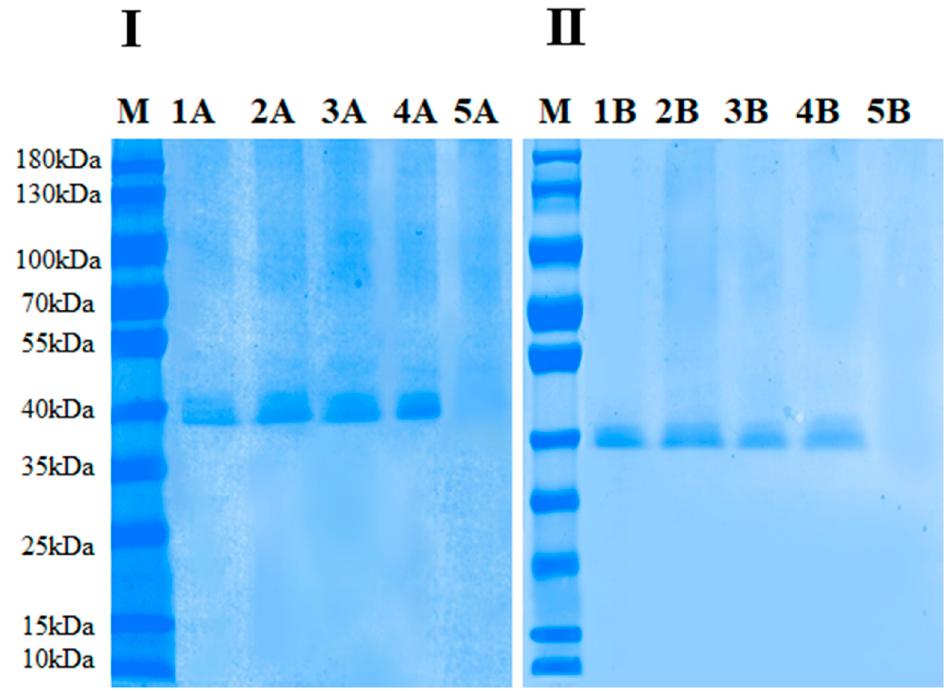
Figure 6. ( I ) SDS-PAGE analysis of the PPO protein: M: Marker, 1A: native PPO, 2A: 25 °C-treated protein (thermal treatment), 3A: 25 °C-treated protein (HPCD treatment), 4A: 65 °C-treated protein (thermal treatment), 5A: 65 °C-treated protein (HPCD treatment); ( II ) Native PAGE analysis of PPO protein: M: Marker, 1B: native PPO, 2B: 25 °C-treated protein (thermal treatment). 3B: 25 °C-treated protein (HPCD treatment), 4B: 65 °C-treated protein (thermal treatment), 5B: 65 °C-treated protein (HPCD treatment).